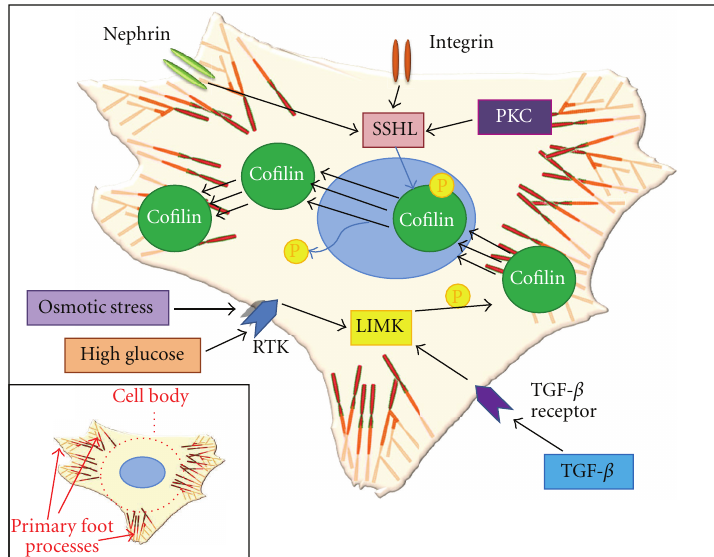
Figure 2: Central role of cofilin in podocyte e ff acement TGF- β or high-glucose stimulation triggers cofilin-1 phosphorylation. Phosphorylated/inactivated cofilin-1 undergoes translocation from cytoplasma to nucleus and is therefore not able to bind and promote F-actin rearrangement. Nephrin and integrin cluster or PKC activate the cofilin-1 via SSH1L activation. A rapid turnover of cofilin-1 is essential for the actin cytoskeleton dynamics in podocyte to perpetuate podocyte integrity. Secondary foot processes of podocyte are not shown here. Secondary foot processes are fine actin-rich processes that sprout out of primary processes and interdigitate with foot processes of neighbouring